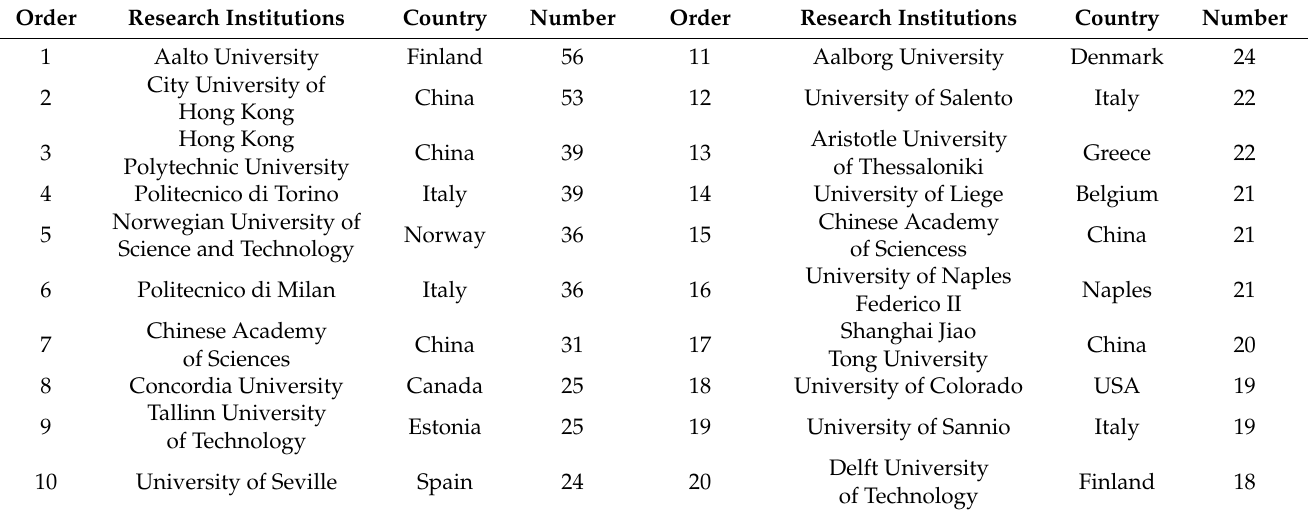
Table 2. Top 20 institutions and countries conducting zero-energy building